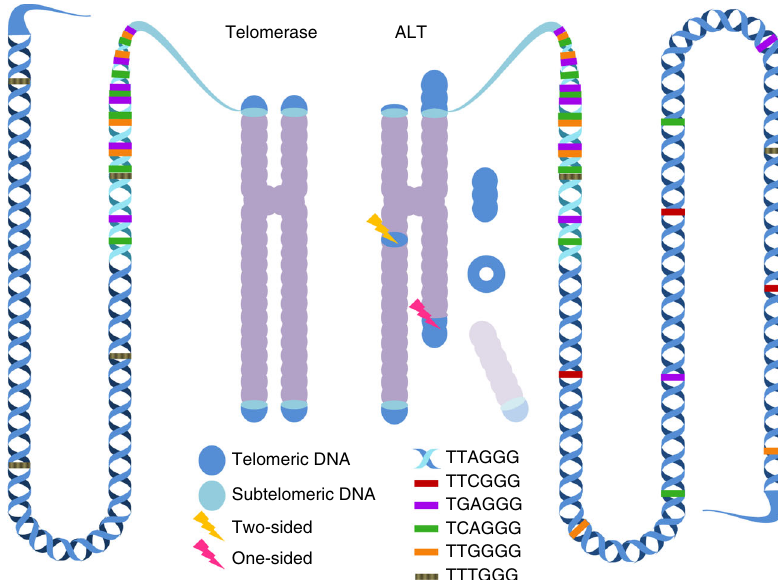
Fig. 5 Genomic footprints of telomerase-mediated telomere elongation and ALT. It is known that telomeres elongated by telomerase have a homologous length with few TVRs in distal telomeric regions (left), while ALT telomeres have heterogeneous lengths with an increased amount of TVRs (right). Moreover, ALT cells have abundant extrachromosomal telomeric sequences. From this study, we conclude that the chromosomes of ALT cells have a higher number of aberrant interstitial telomere insertions, most of which are one-sided and accompanied by a loss of the adjacent chromosomal segment. We also showed that several TVRs occurring as singletons are more abundant in ALT telomeres, while one singleton (TTTGGG) was more abundant in telomerase-elongated telomeres. Please note that it is currently undetermined whether the different types of singletons are located in proximal or distal telomeric